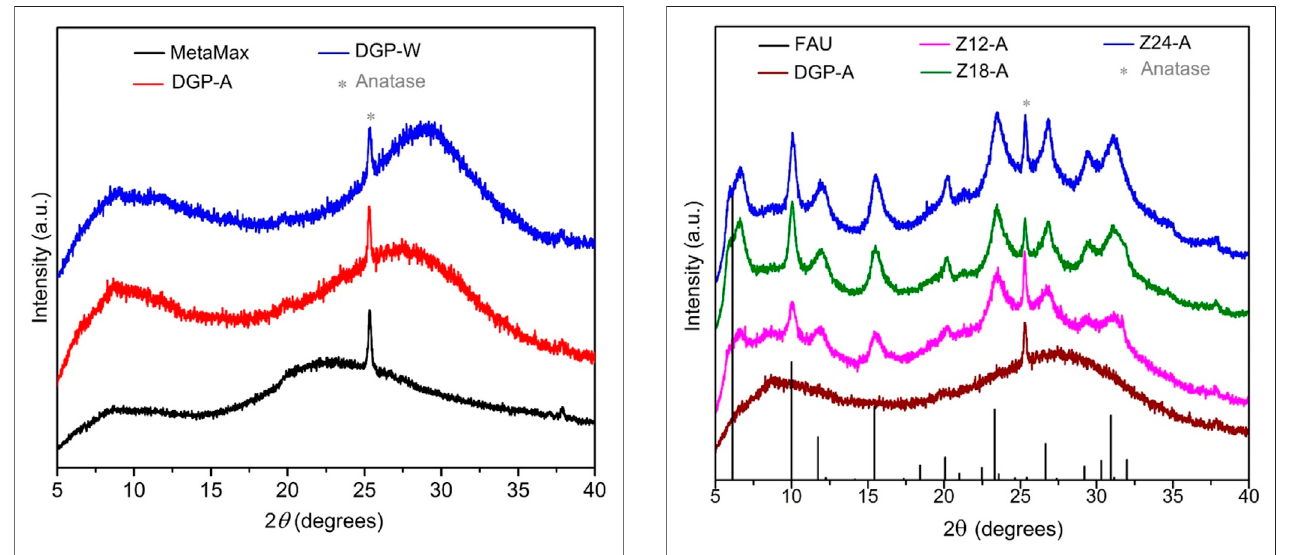
FIGURE2 | Stacked powder X-ray diffraction patterns ofsamples DGP- A, Z12-A, Z18-A and Z24-A (bottom to top) compared with the simulated powder pattern of NaX zeolite with faujasite (FAU) structure and (*) anatase (TiO 2 at ∼ 25.3 ° 2 θ ; PDF card #